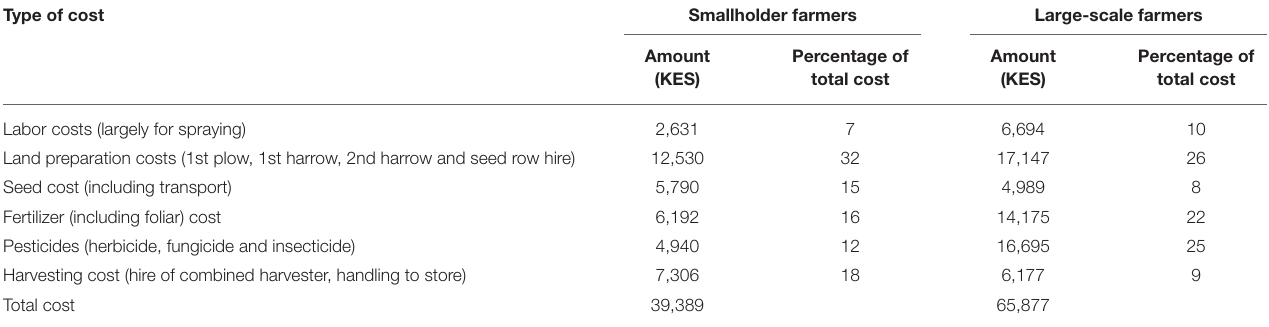
TABLE 2 | Smallholder and large-scale farmer’s costs of production (per